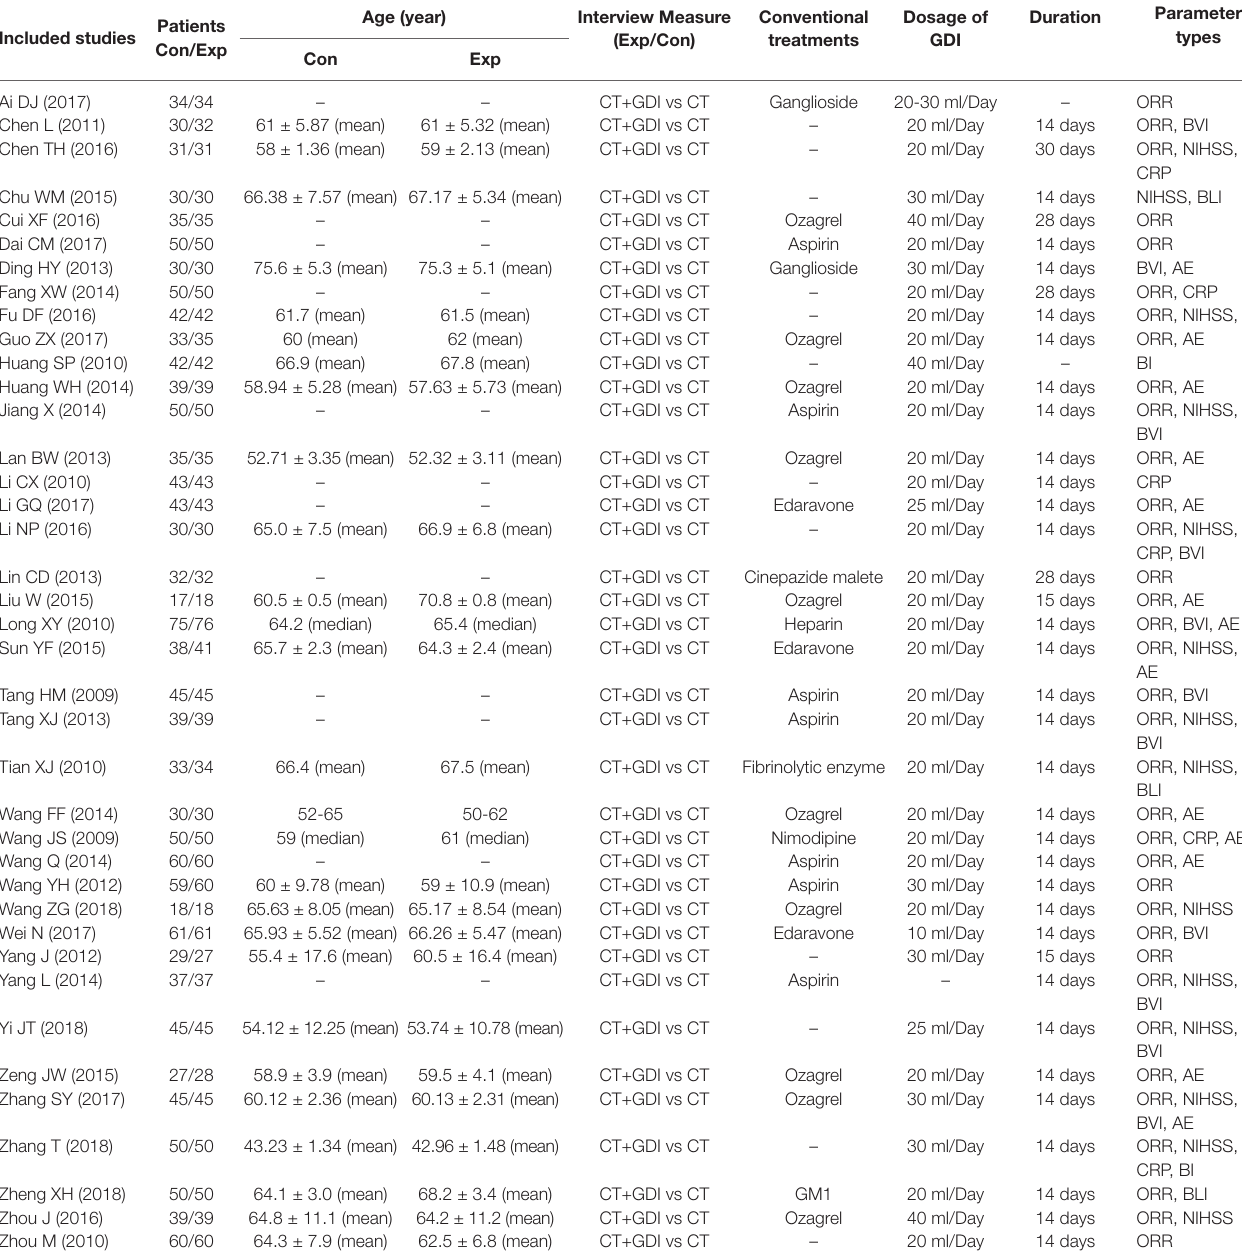
tABLE 1 | Clinical information from the eligible trials in the meta-analysis. Patients Included studies